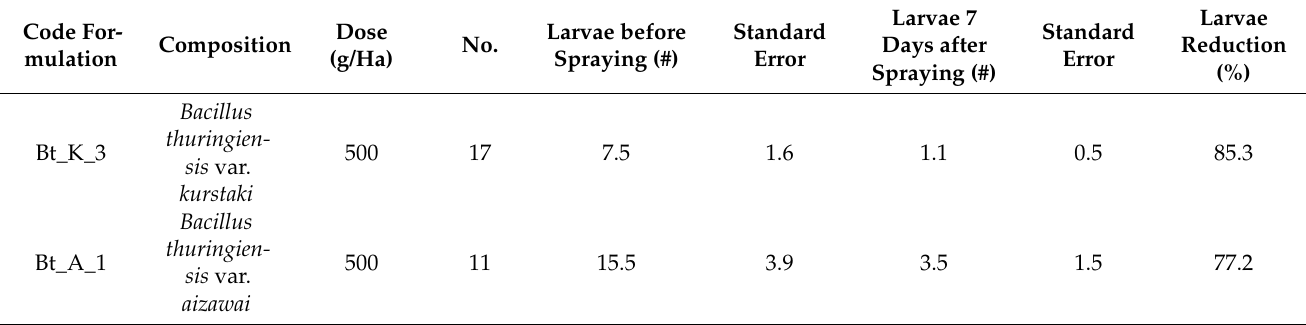
Table 4. Population reduction in Stenoma impressella larvae seven days after being spraying by two Bacillus thuringiensis commercial formulations in different oil palm